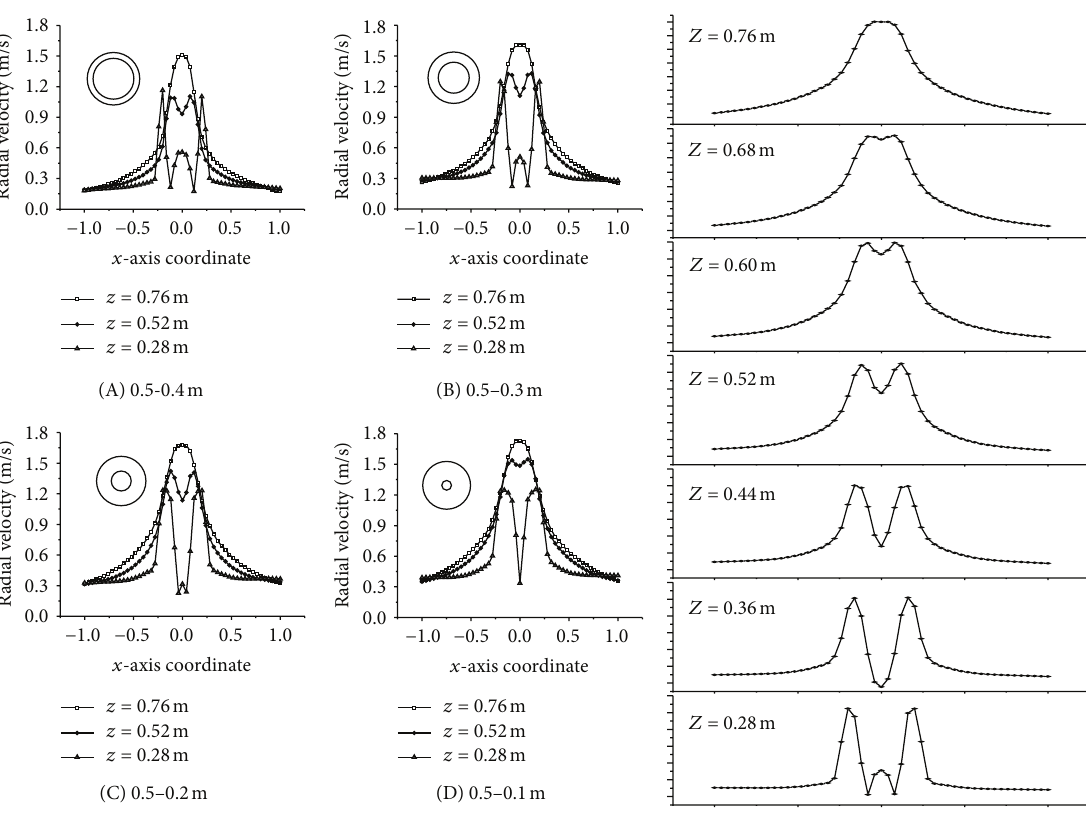
(b) Schematic diagram of radial velocities develop- ment ( 𝐷 0 = 0.50 m 𝐷 𝑖 = 0.30 m)